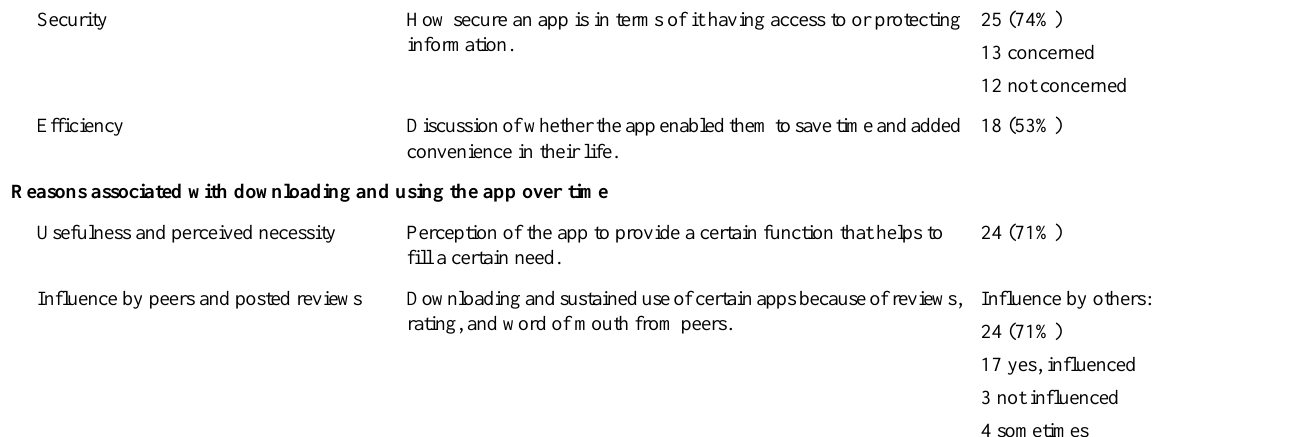
Participant endorsement, n (%)DefinitionTheme 29 (85%) 18 preferred free 11 would 25